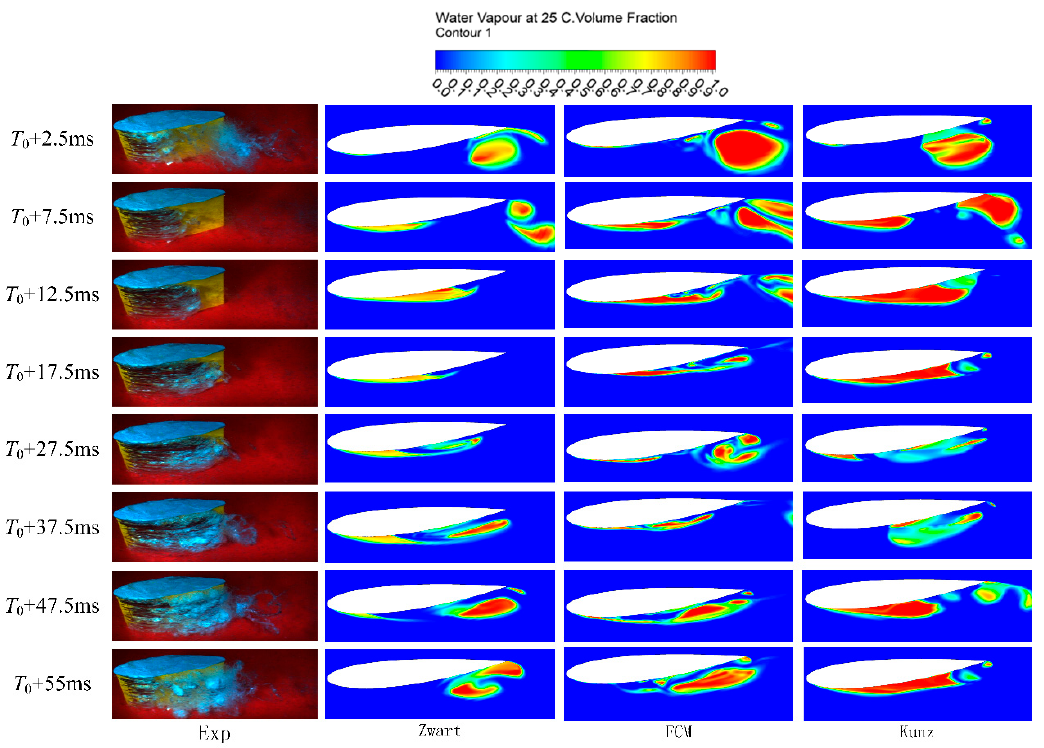
Figure 8. Time evolution of cloud cavitation for the numerical and experimental results ( σ = 0.65, α = 60°).